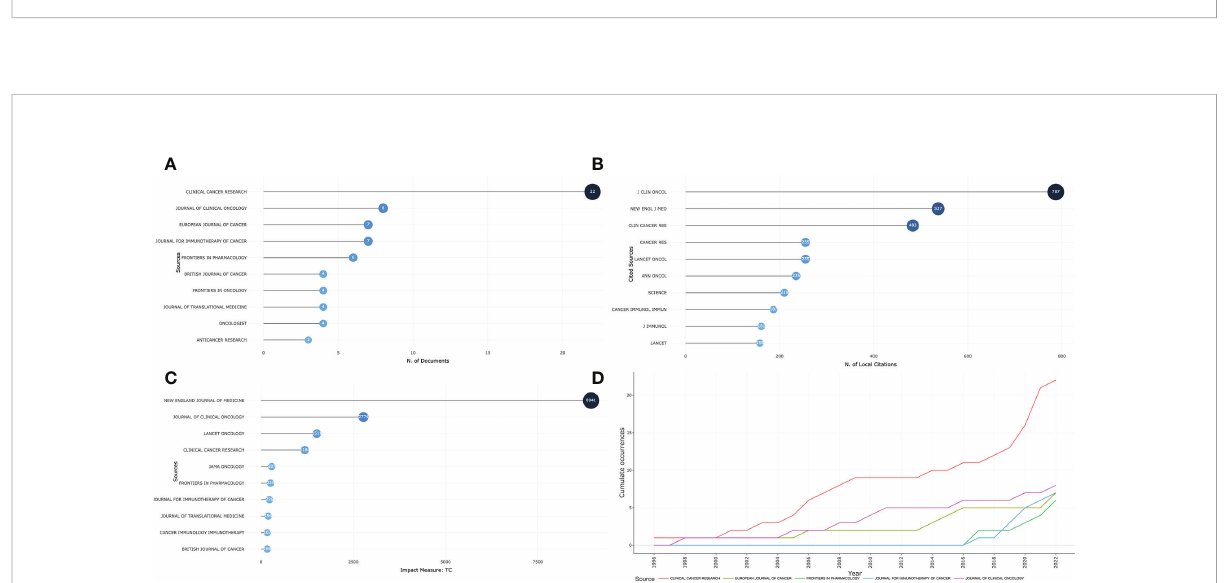
FIGURE 4 Journals contributing to IRAEs for colorectal cancer. (A) Distribution of the top ten journals contributing to the literature. (B) Distribution of the top 10 journals with the highest number of citations in published literature. (C) The 10 most in fl uential journals in the fi eld. (D) Growth curve of the number of journals publishing in the fi eld per year.